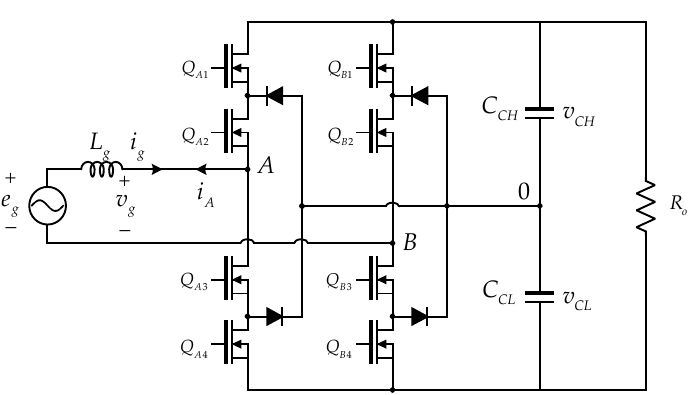
Figure 3. The single-phase NPC inverter topology.